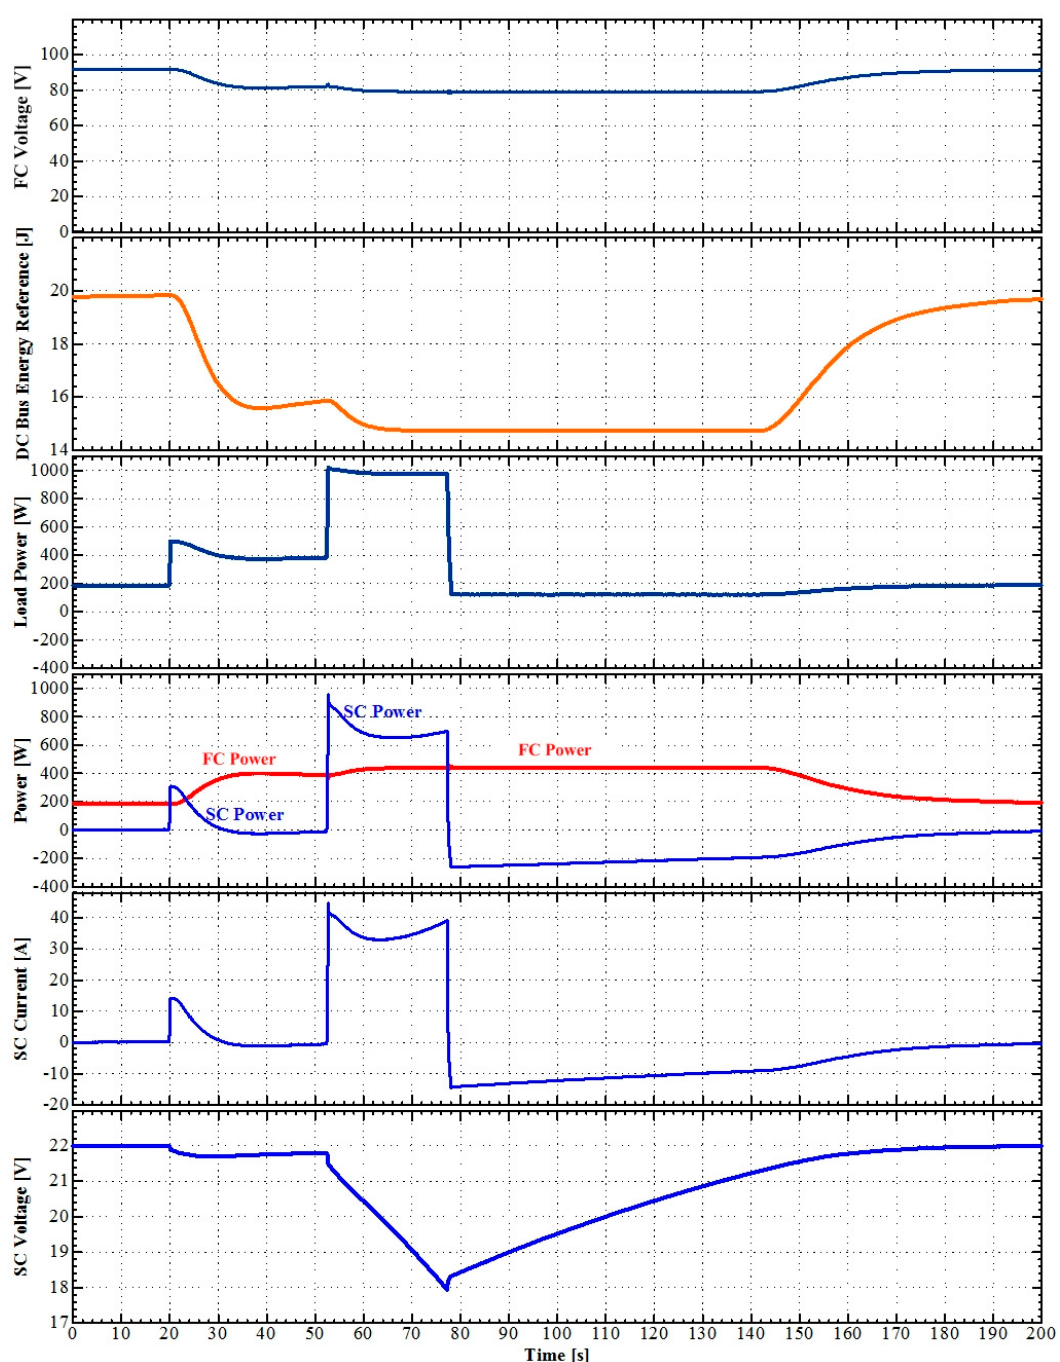
Figure 17. Obtained experimental results in motoring and ride-through